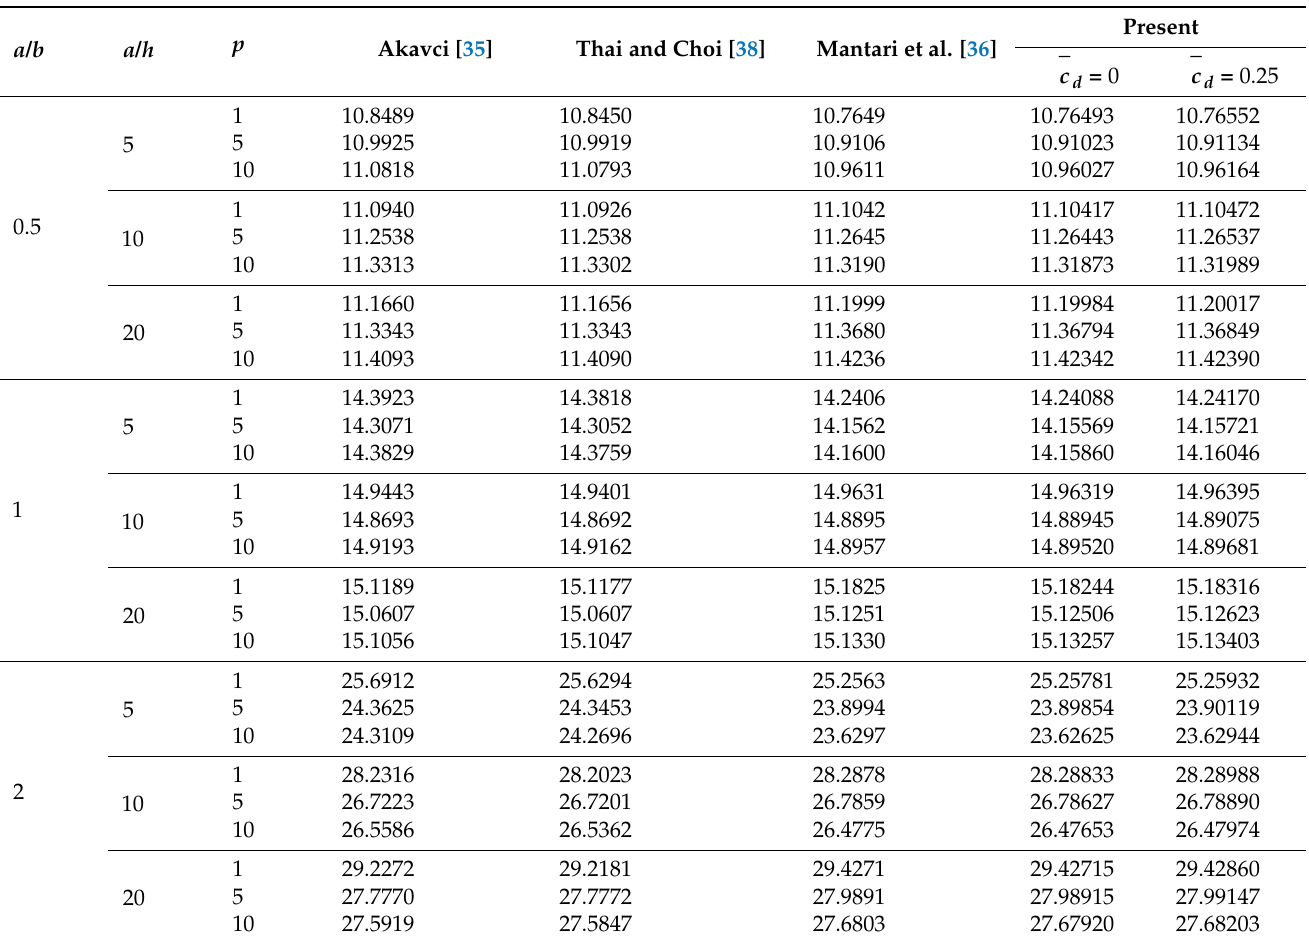
Table 13. Non-dimensional fundamental frequencies ˇ ω = rectangular plates resting on visco–Pasternak foundations ( k w = 0, k s = 100).